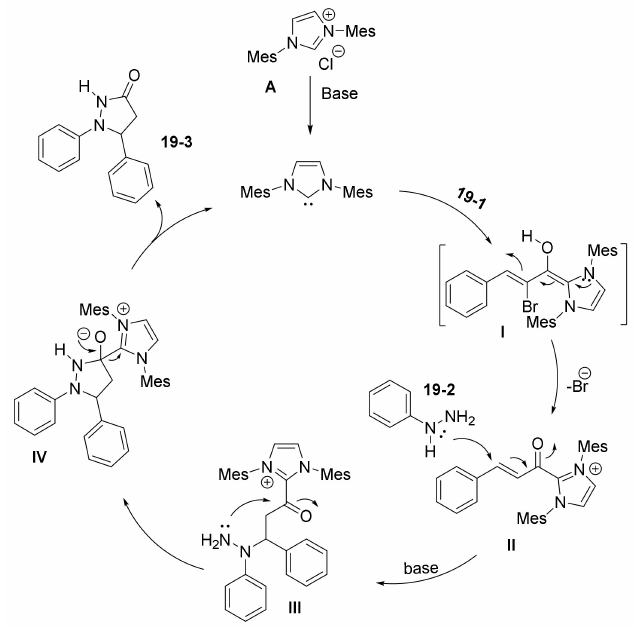
Scheme 38. Proposed catalytic cycle for the synthesis of